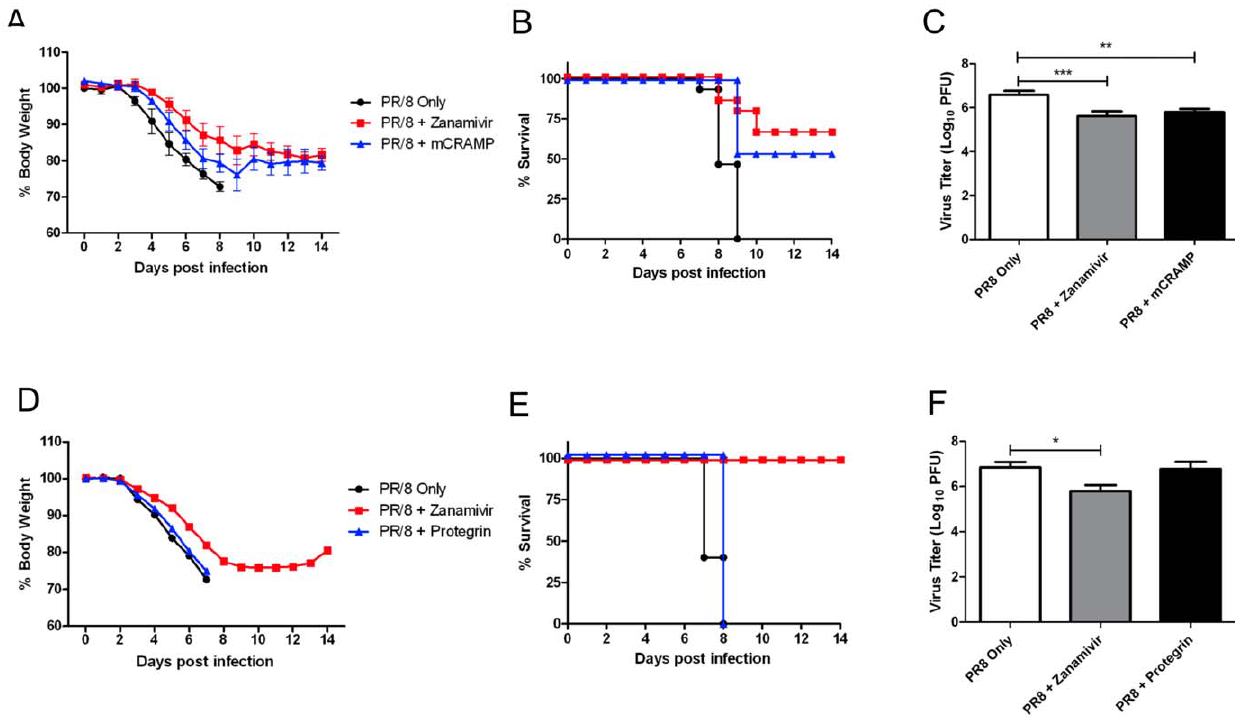
Figure 2. Cathelicidins Show Species-Specific Antiviral Effects. (A,B,D,E) Groups of 5 mice were infected with 10 MLD 50 of A/PR/8/34 influenza virus via intranasal administration on day 0. Mice were nebulized with 200 m l of saline (control), zanamivir (500 m g/ml), the murine cathelicidin mCRAMP (500 m g/ml) (A and B) or the porcine cathelicidin Protegrin-1 (500 m g/ml) (D and E) once daily from day -1 to day 7. Mouse body weight (A, D) and survival (B, E) was monitored daily up to 14 days post infection. Data represent mean values 6 SEM, for three independent experiments (A and B) or one experiment (D and E). Statistical analysis was performed using Kaplan Meier with a Mantel-Cox (log rank) test. Survival curves obtained with Zanamivir and mCRAMP treatments were significantly different (P # 0.001) compared to saline control treatment. There was no difference between saline treated and Protegrin treated groups. (C, F) Groups of three mice were infected with 10 MLD 50 of A/PR/8/34 virus via intranasal administration on day 0. Mice were nebulized with 200 m l of saline (control), zanamivir (500 m g/ml), the murine cathelicidin mCRAMP (500 m g/ml) or the porcine cathelicidin Protegrin-1 (500 m g/ml) once daily from day -1 to day 2. Mice were euthanized on day 3 and viral titer in the lungs was assessed by plaque assay. Figure shows mean values 6 SEM. Statistical analysis was performed using an unpaired t-test to compare virus infected animals with virus/peptide and virus/zanamivir treated animals (*P # 0.05, **P # 0.01, ***P # 0.001).